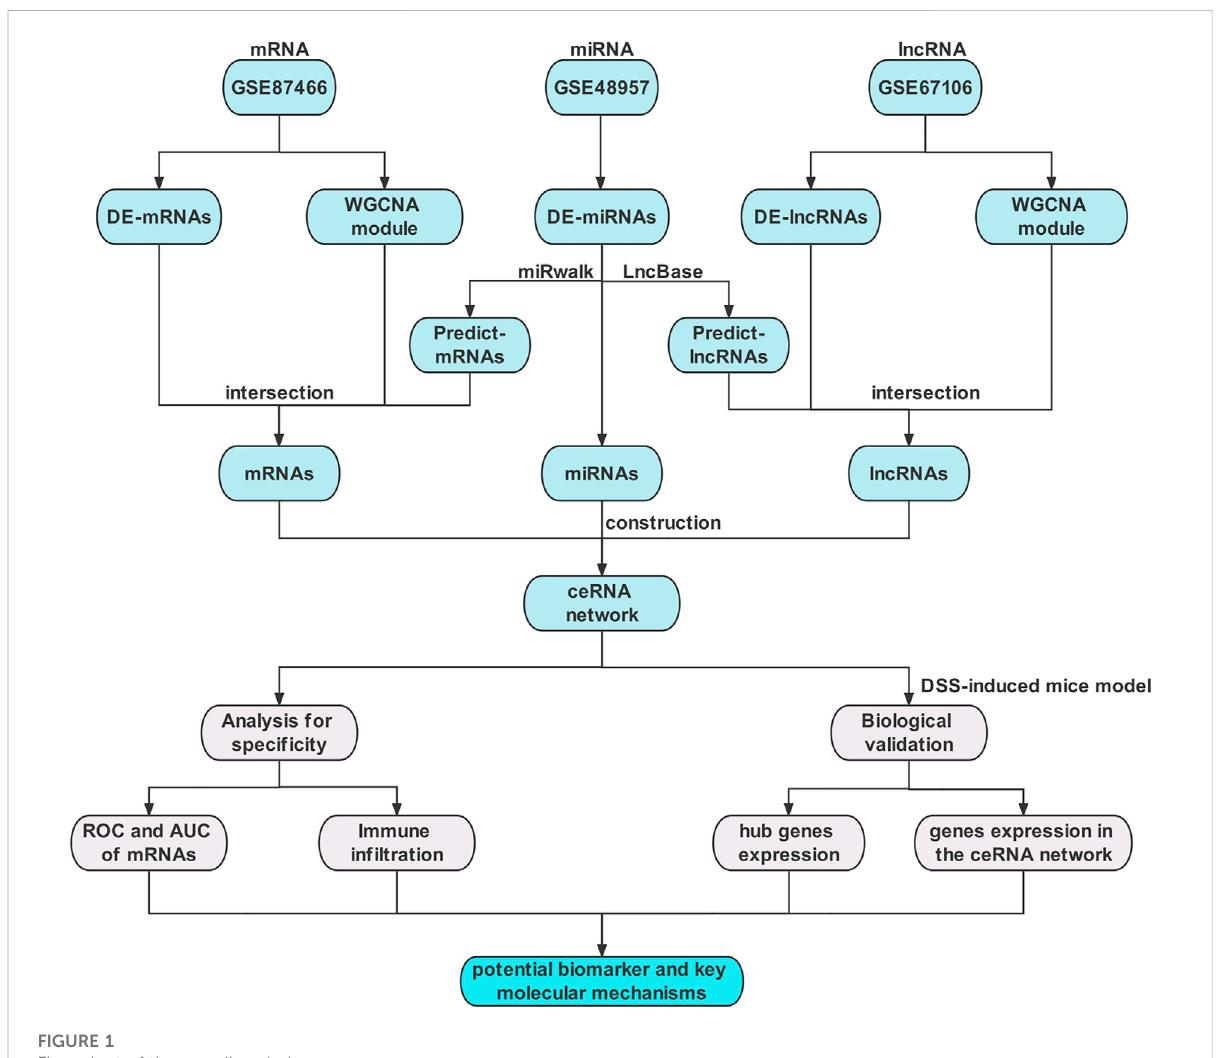
FIGURE 1 Flow chart of the overall analysis.